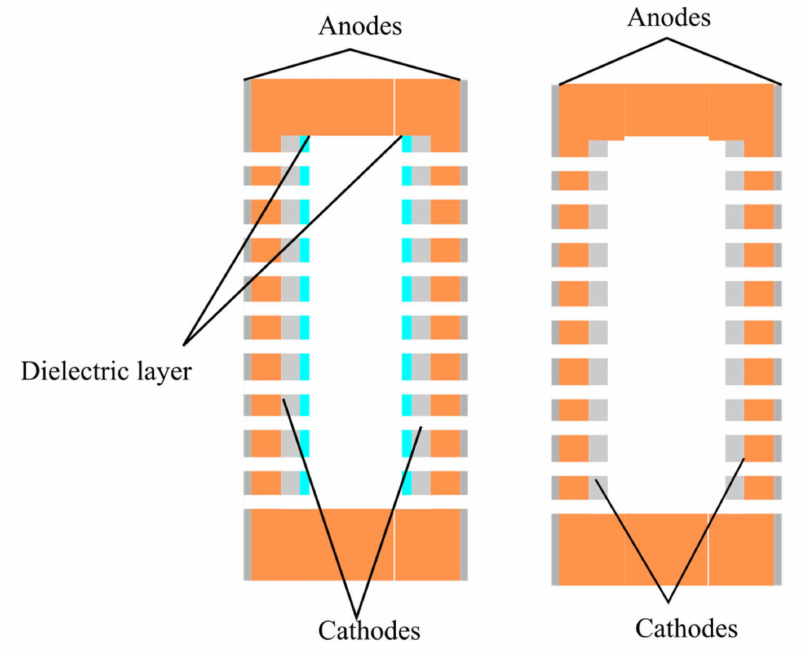
Figure 1. Two configurations of the signal converting cell. The left one shows Option 1, the configura- tion with a dielectric layer; the right one shows Option 2, the configuration without a dielectric layer. The difference between the two studied configurations is that in Option 1 (Figure 1, left), the side of the cathodes parallel to the surface of the plates is covered with a dielectric layer, and, in Option 2 (Figure 1, right), it is left